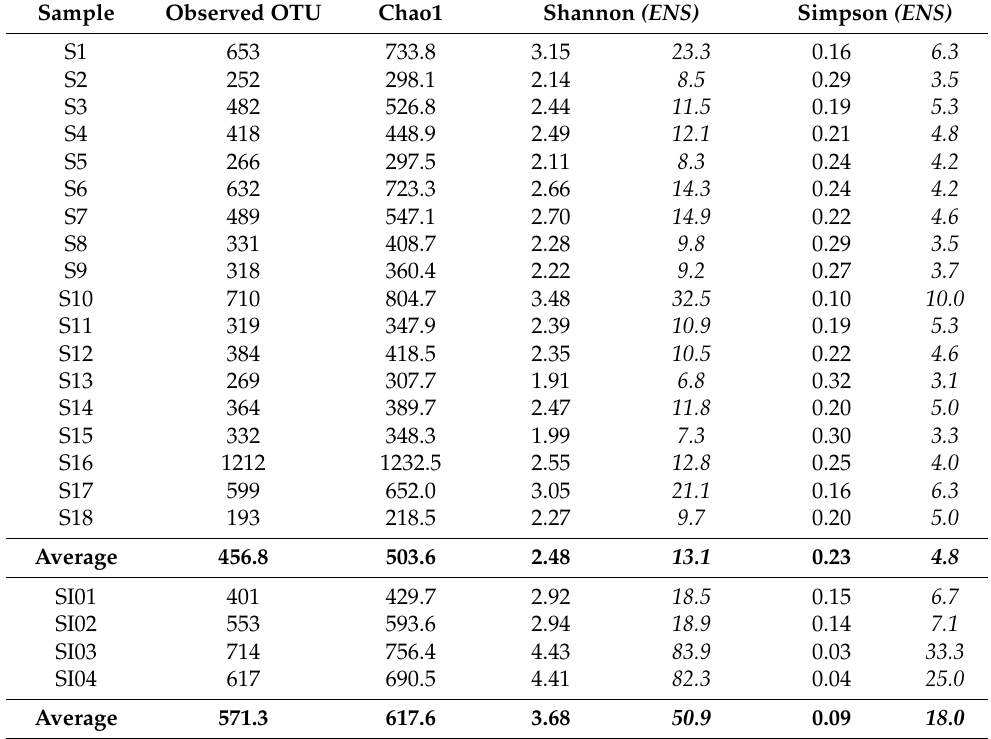
Table 5. Alpha-diversity indices (Chao1, Shannon and Simpson indices) for the bacterial OTUs assigned from 18 lichen samples from the Syowa Station region in continental Antarctica (S1–S18) and four samples from Signy Island in maritime Antarctica (SI01–SI04). Effective numbers of species ( ENS ) values were calculated from the Shannon and Simpson